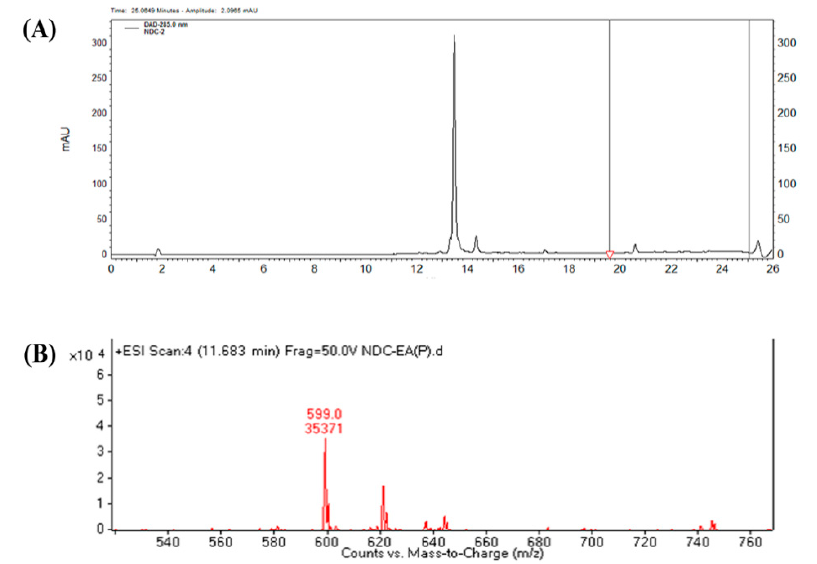
Figure 6. HPLC and LC-MS analyses of naringin DC’s major product produced by CYP102A1 M221 mutant. (A) preparative-HPLC chromatogram of the major product of naringin DC (C18 column, 10 × 150 mm, gradient from 10% to 100% methanol, 3 mL / min). (B) LC-MS analyses of the major product DC [M+H] + 599 ( m/z 598).